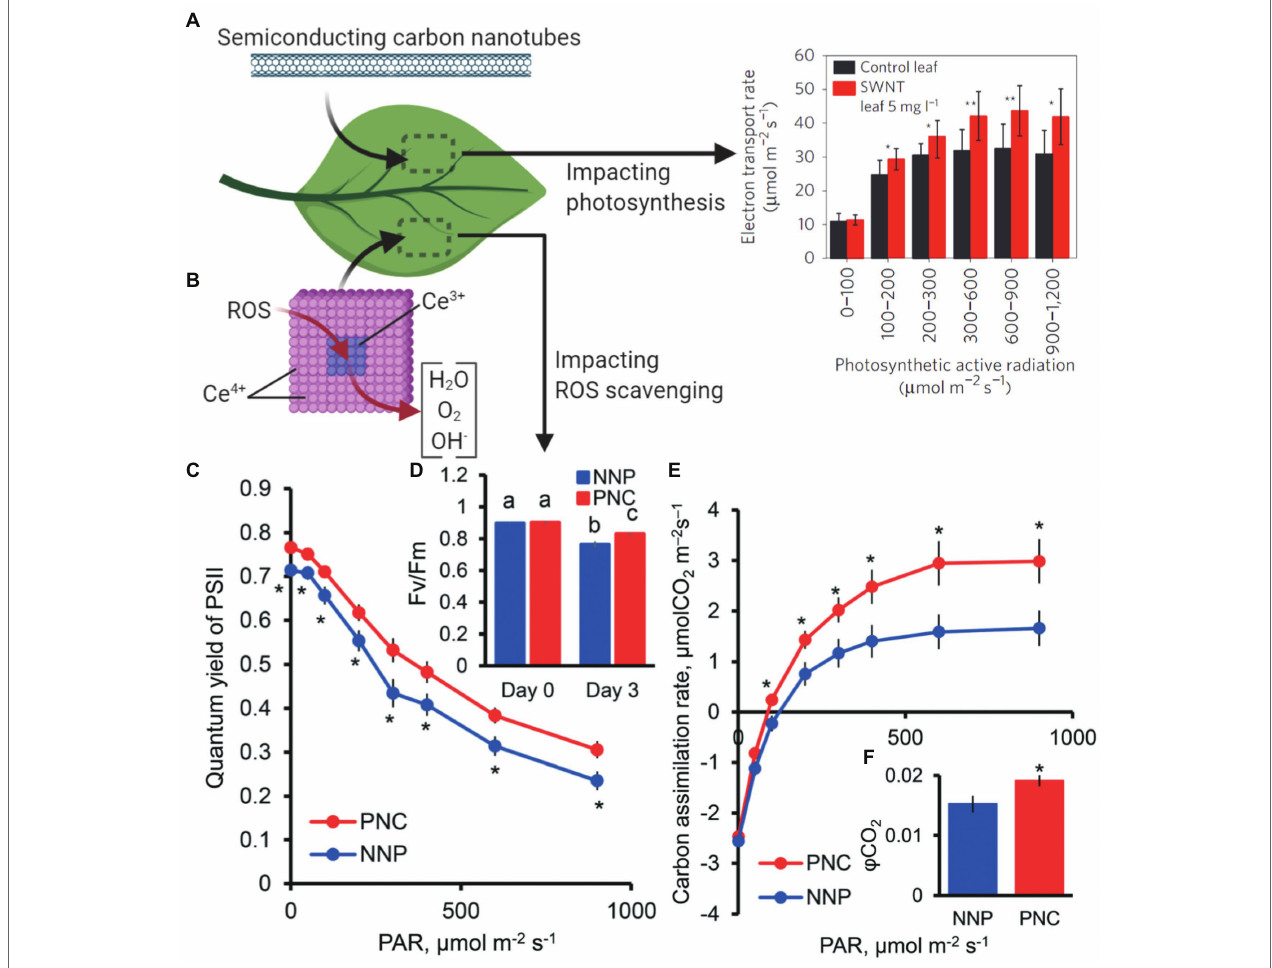
FIGURE 6 | Nanotechnology approaches to improve plant photosynthesis. (A) SWCNTs interfaced with plant leaves increase chloroplast photosynthetic activity (Material from Giraldo et al., 2014). (B) Cerium oxide nanoparticles catalytically scavenge reactive oxygen species (ROS) in chloroplasts, resulting in enhanced light and carbon reactions of photosynthesis. Stressed plants with poly acrylic-coated cerium oxide nanoparticles (PNC) have higher (C) PSII quantum yields, (D) maximum PSII efficiency (Fv/Fm), (E) carbon assimilation rates, and (F) quantum yield of CO 2 relative to controls without nanoparticles (NNP; Reproduced from Wu et al., 2018 with permission from the Royal Society of Chemistry). * p < 0.05; ** p < 0.01. Different lower case letters mean significant differences at p <